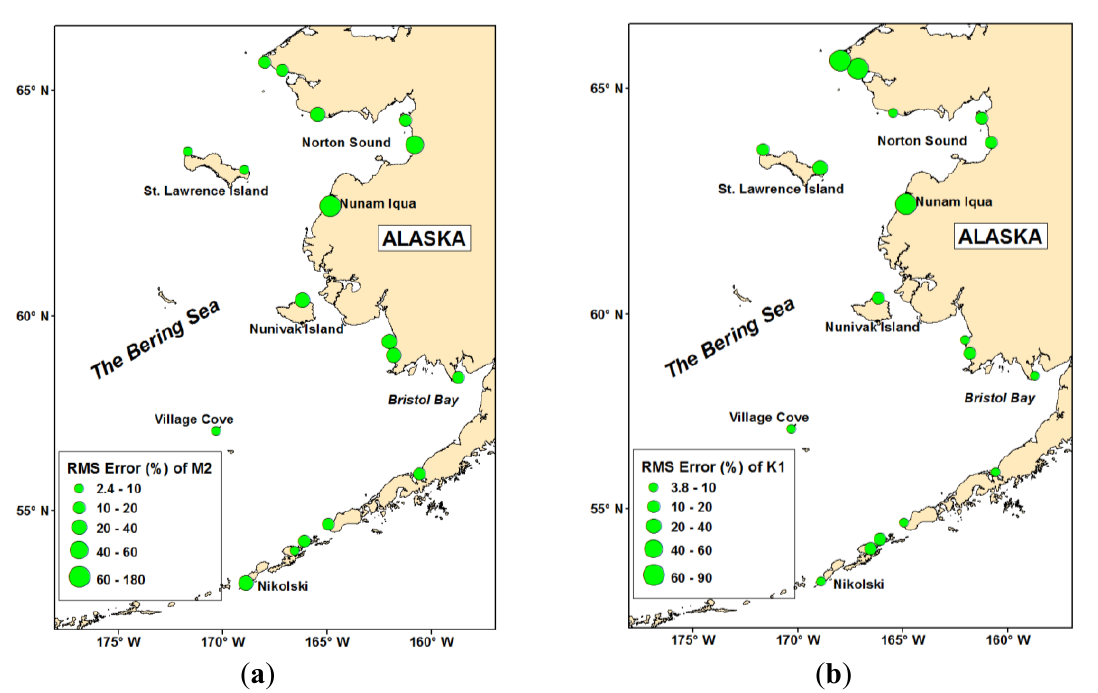
Figure 7. The spatial distribution of the relative RMSE (%) of Foreman’s model (FM) for ( a ) M ; and ( b ) K 2 1